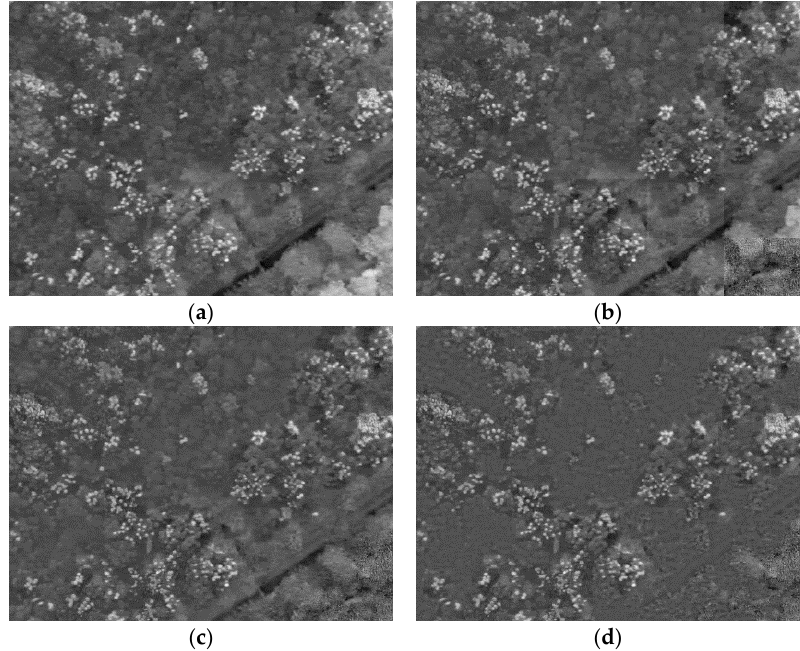
Figure 16. Detection maps of 4 algorithms in Region 2. ( a ) CEM ( b ) Subset CEM ( c ) Sliding Window- based CEM (SW CEM) ( d ) Adaptive Window-based CEM (ASW CEM).